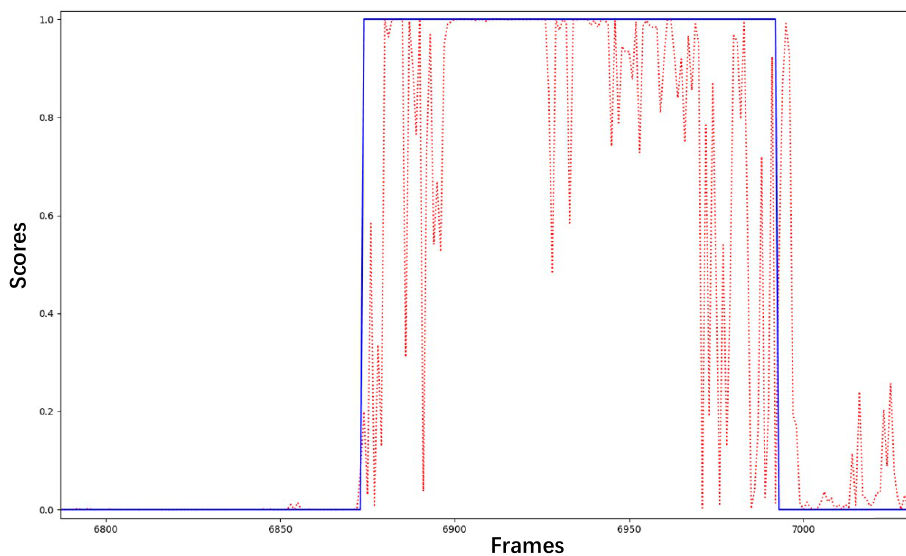
Figure 5. Action estimation network predicts the comparison of the score curve with the label.